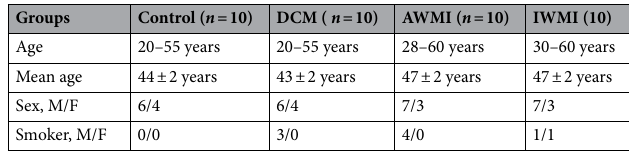
Table 1. Characteristics of clinical sample